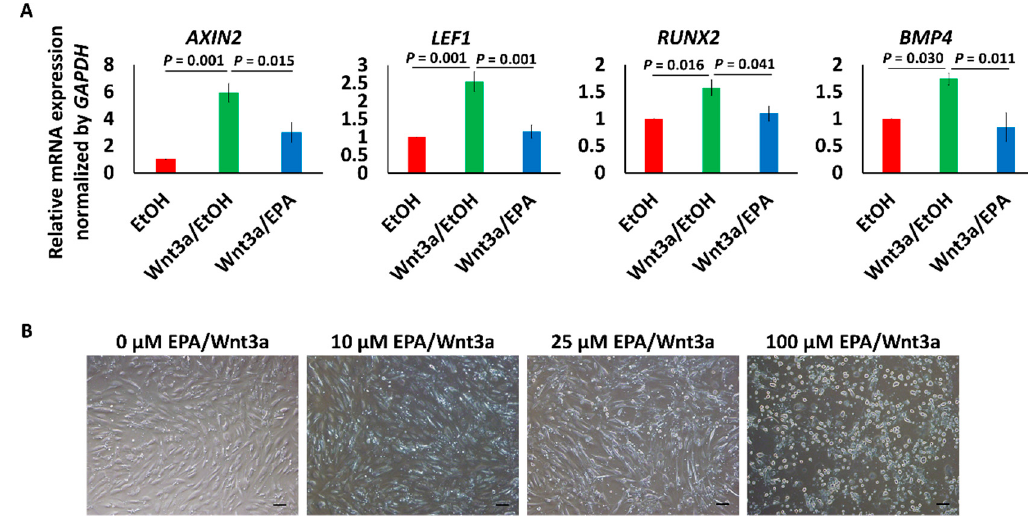
Figure 3. Effects of Wnt3a and EPA on human aortic smooth muscle cells (HAoSMCs). ( A ) Changes of the gene expression pattern in HAoSMCs treated with or not treated with 100 ng/mL Wnt3a and/or EPA. Data are shown as means ± SE ( n = 4 in each group), and were analyzed using one-way ANOVA with Tukey’s post hoc test. EtOH means ethanol; ( B ) Cytotoxicity of EPA in HAoSMCs. Bar = 100 μ m.